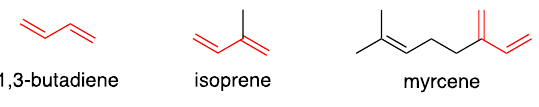
Figure 2. Industrially relevant 1,3-dienes.